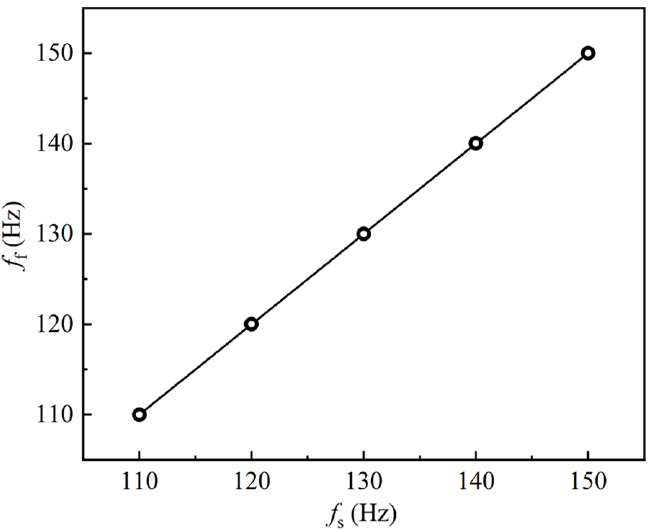
Figure 4. Frequency f f of flame oscillation induced by acoustic disturbance of different frequencies f s .